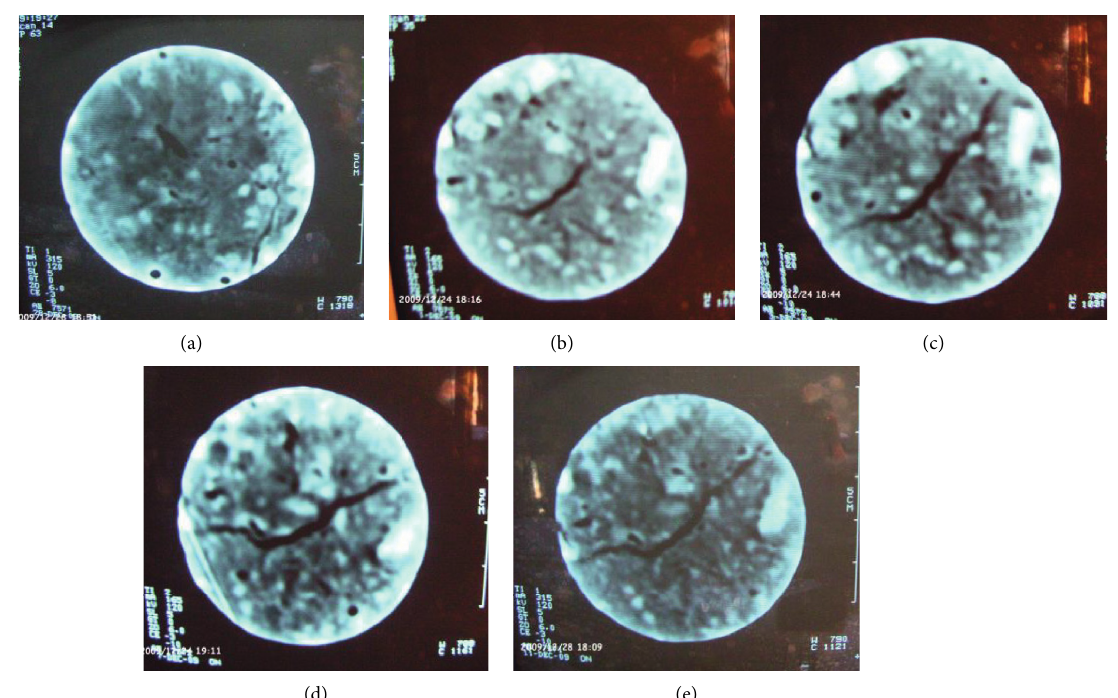
Figure 16: CT images of the a section position of the LC-2 sample with cycle amplitude Δ w � 20%. (a) Zero cycles. (b) One cycle. (c) Two cycles. (d) Four cycles. (e) Six